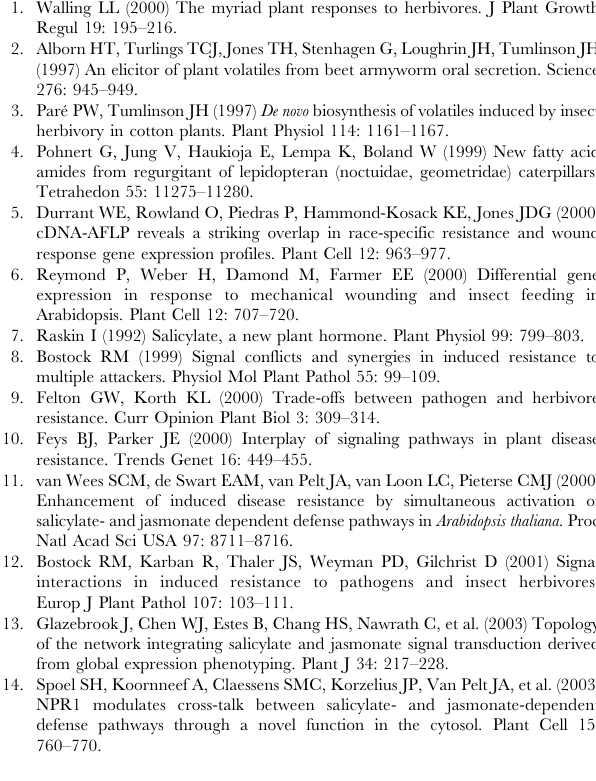
combinations (e.g., 1a, 2a, etc.) after the underscore indicate independent biological replicates of a given treatment. Data MATERIALS AND METHODS.